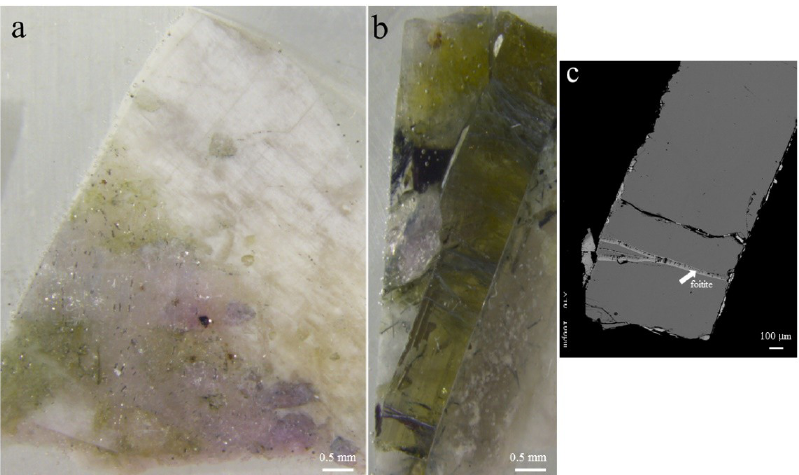
Figure 10. Optical microscope images of sample 9a ( a ), 9b ( b ) and BSKE image of sample 9b ( c ) where the arrow indicates the foitite.